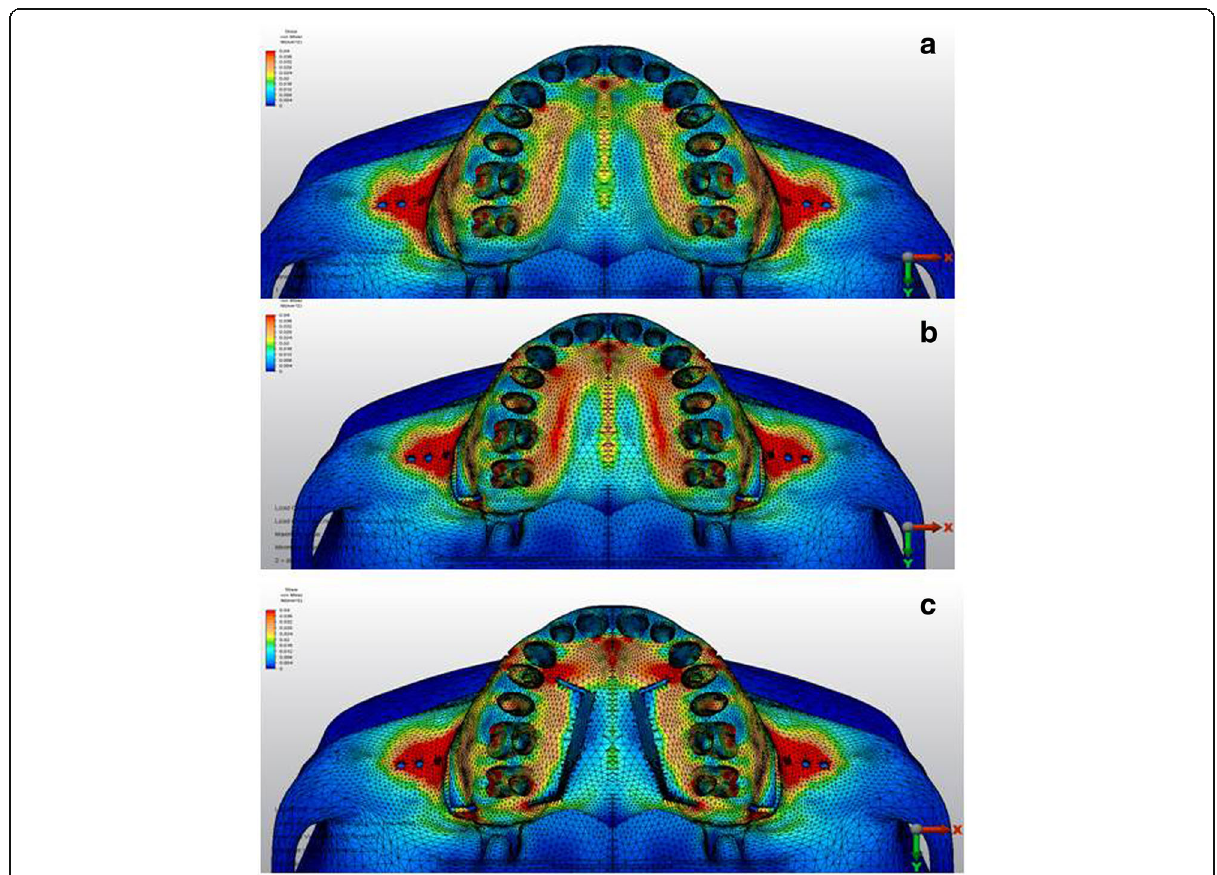
Fig. 4 Stress distributions from occlusal view over cortical bone a first, b second, and c third scenarios